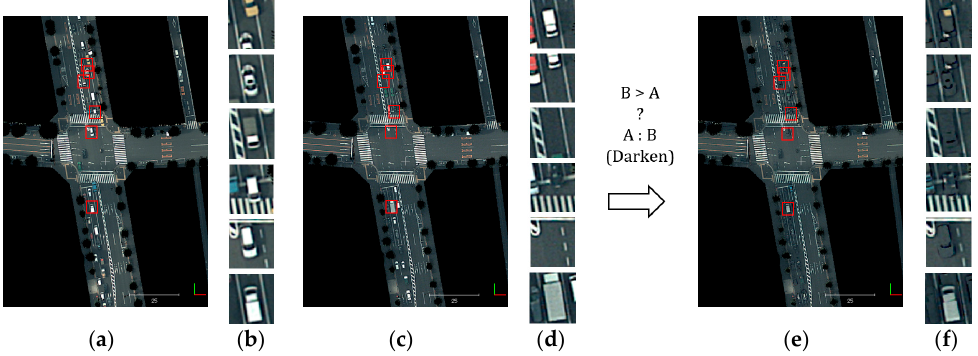
Figure 6. Filtering moving vehicles from aerial image: ( a ) first aerial image; ( b ) enlarged view of some vehicles in the first image; ( c ) second aerial image; ( d ) enlarged view of the same areas in the second image; ( e ) vehicle filtering result; and ( f ) enlarged view of the same areas in the filtered result, showing both filtered vehicles and a non-filtered vehicle.